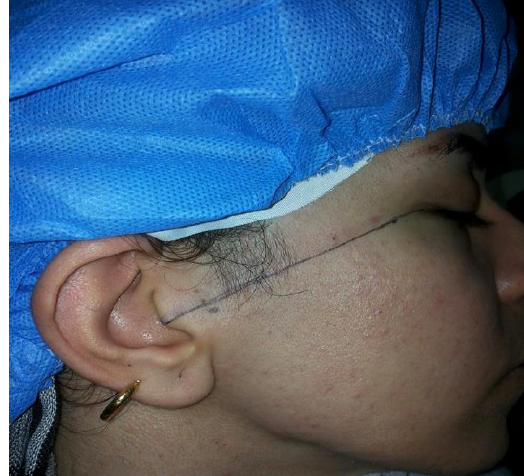
Figure 2: Illustrates the preparation of patient and points on the canthotragal line.